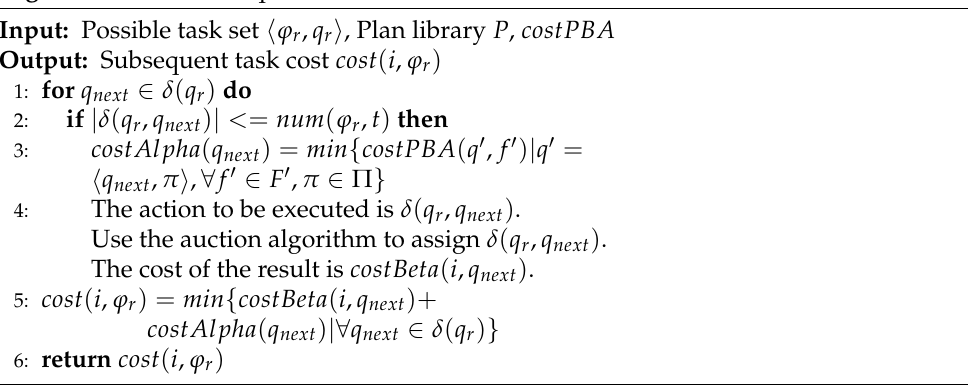
Algorithm 3 The subsequent task cost